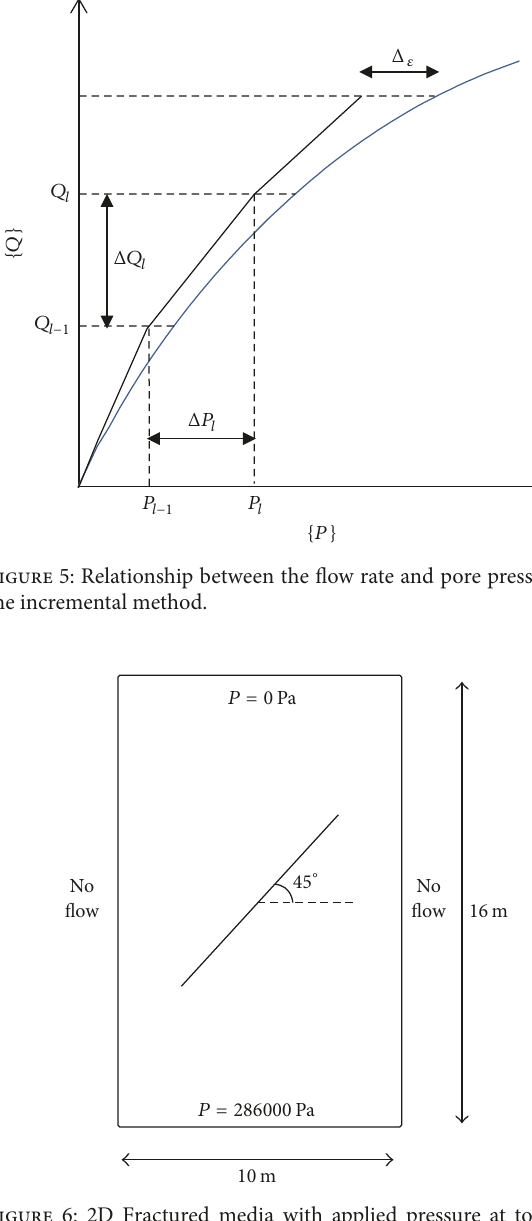
length of the fracture is 𝐿 = 8 m, 𝐾 𝑓 = 0.08 m 2 , and 𝐾 𝑚 = 8 × 10 −6 m 2